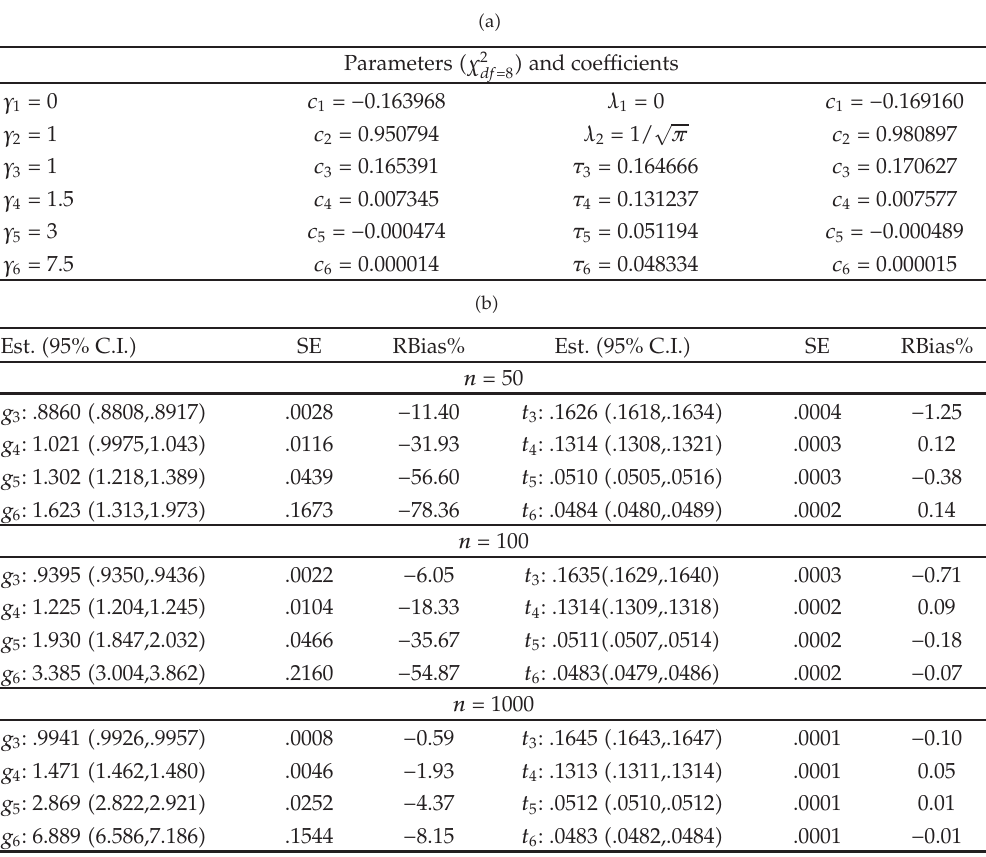
Table 4: Overall average estimates (cid:2) Est. (cid:3) , bootstrap confidence intervals (cid:2) C.I. (cid:3) , standard errors (cid:2) SE (cid:3) , and percentage of relative bias (cid:2) RBias% (cid:3) for the conventional moment-based statistics (cid:2) g (cid:3) and L- moment ratios (cid:2) t (cid:3)